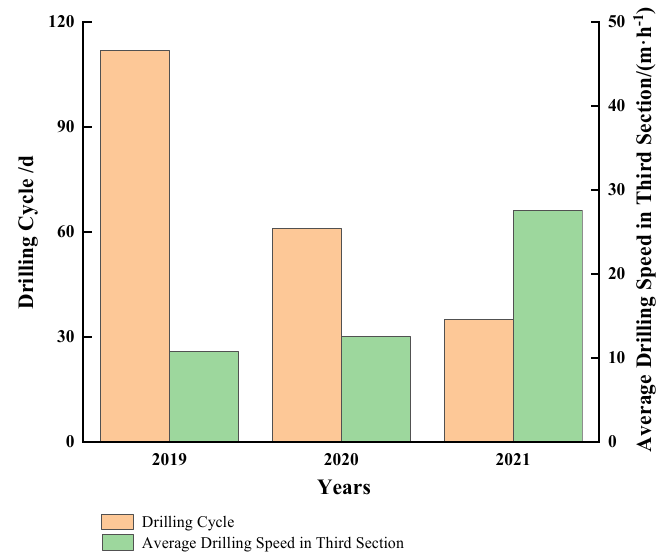
Figure 13. Annual comparisons of drilling period and ROP.